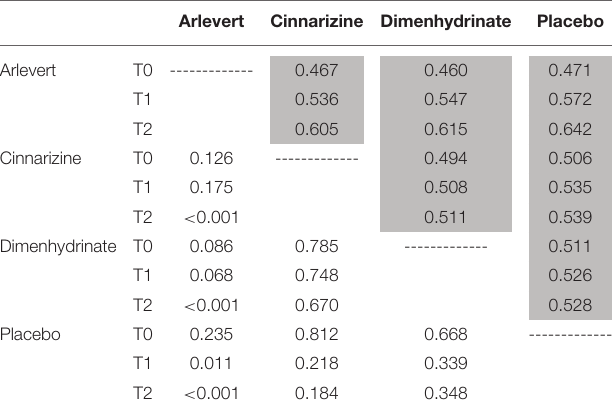
TABLE 1 | Selected results of multivariate data